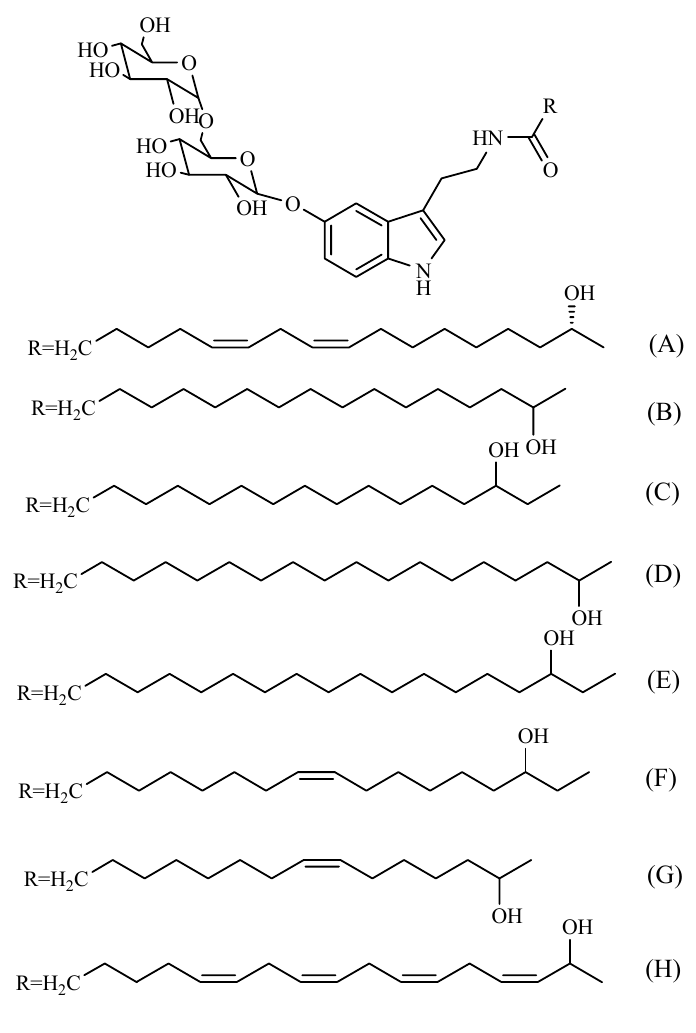
Figure 6. Different withanamides (A-I) isolated from W. somnifera